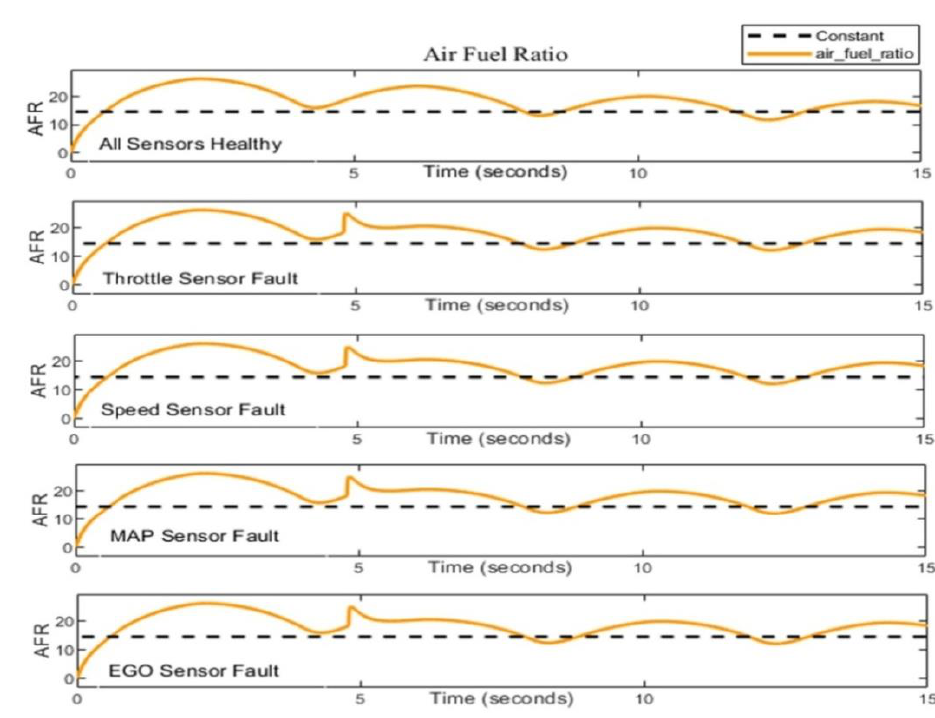
Figure 13. Matlab Diagram for PFTCS Part.